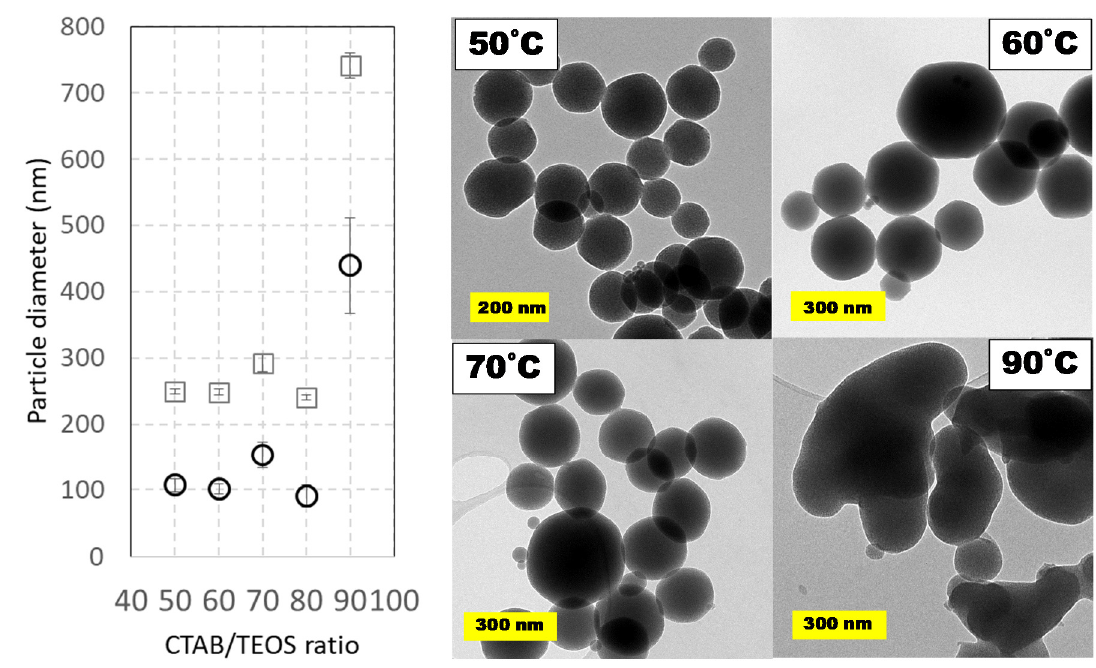
Figure 5. Particle size distributions and TEM images of prepared MCM-41 like MSNs at several temperatures from 50 to 90 °C. Squares ( ) are used for hydrodynamic diameters measured by DLS values and circles ( ) for diameters obtained from TEM micrographs. Experimental conditions: 1 L round-bottom flask reactor with 0.5 L working volume and magnetic stirring (800 rpm). Reactions were carried out at variable temperatures using TEOS (5 mL, 0.5 mL · min − 1 ) and CTAB (1 g, 2 g · L − 1 ) during a 60 min. Data shown correspond to samples C1 to C6 in Supplementary material.